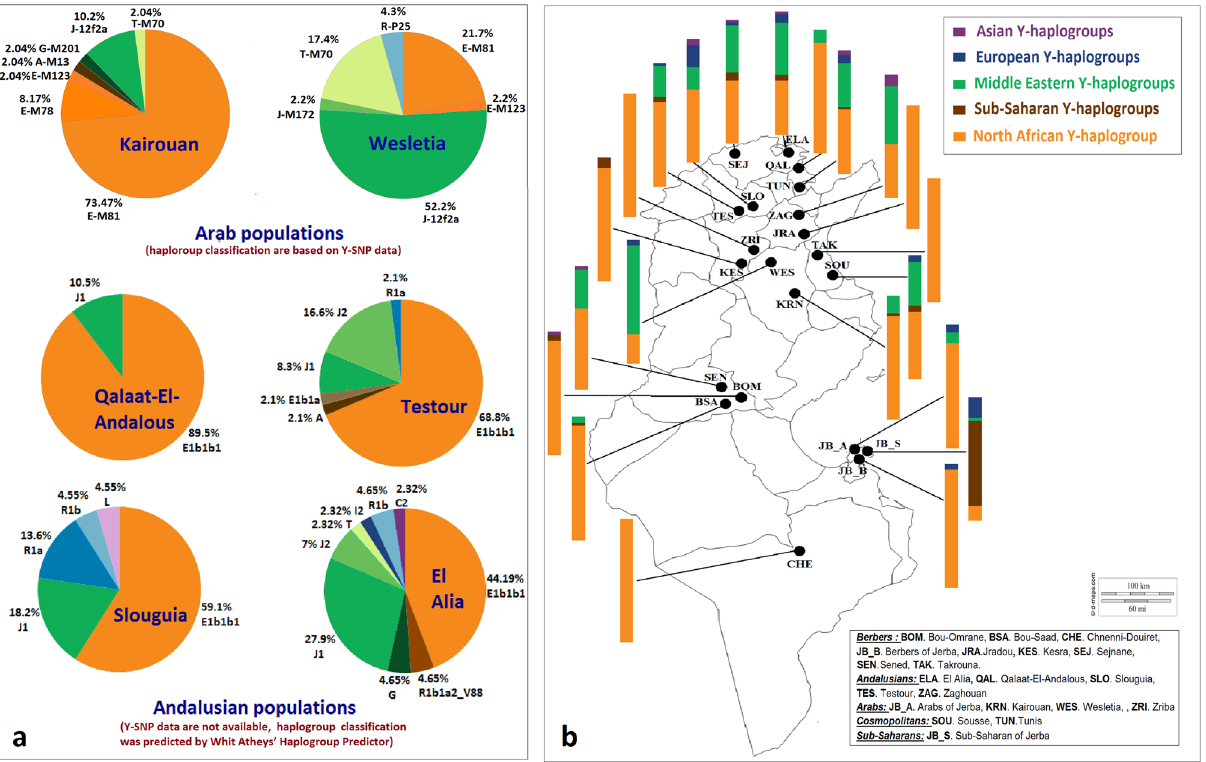
Figure. 1. Distribution of Y-chromosomal haplogroups in Arab and Andalusian populations ( a ) and in 21 Tunisian populations ( b ) (details of Y-Chromosome haplogroups frequencies in Supporting Information Table